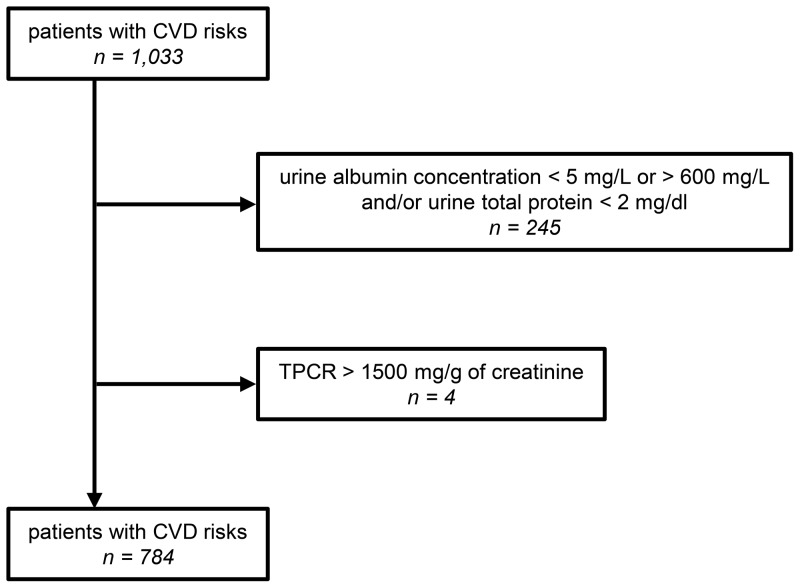
Inclusion criteria.Of the 1,033 adult patients from the cardiovascular clinic at St. Luke's International Hospital, 249 patients who presented with out-of-measurement range or the TPCR>1500 mg/g of creatinine (150 mg/mmol) were excluded from this study. CVD, cardiovascular disease; TPCR, total urine protein-to-creatinine ratio.